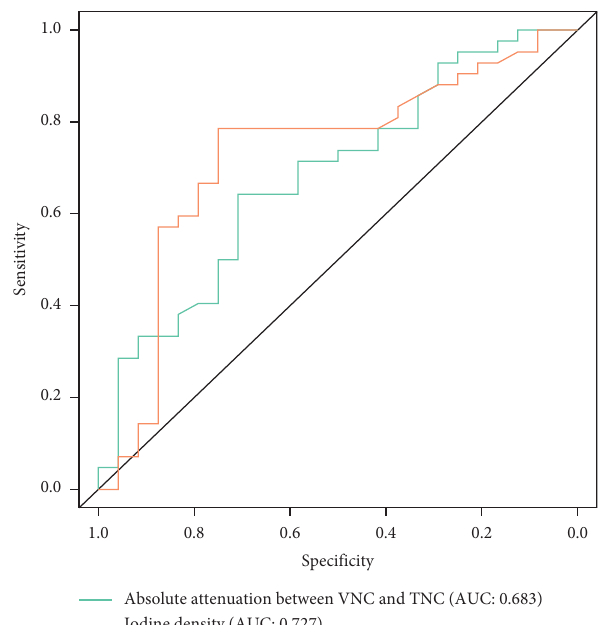
Figure 4: Receiver operating characteristic curve of the absolute attenuation between virtual noncontrast (VNC) and true noncontrast (TNC) images and iodine density for distinguishing papillary carcinoma from nodular